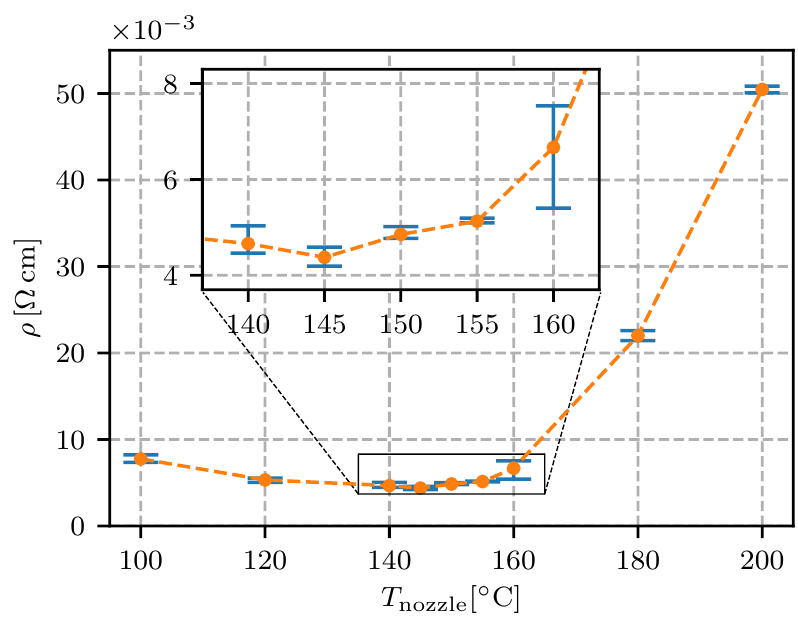
Figure 15. Resistivity for different nozzle temperatures T nozzle with an enlarged optimal range.